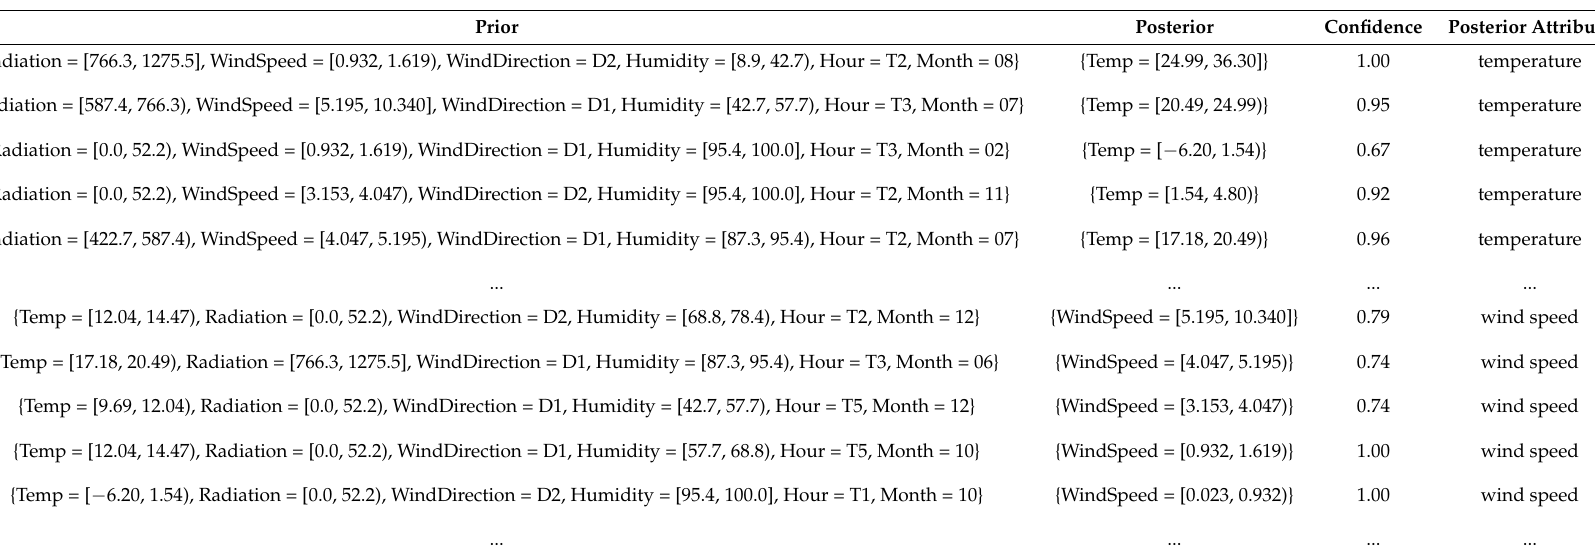
Table 1. Example of the generated association rules with confidence greater than 60% and lift greater than 1 for ambient temperature and wind speed as posterior. Prior Posterior Confidence Posterior